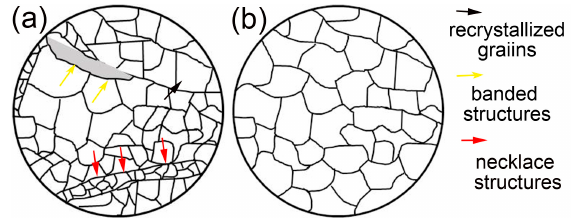
Figure 9. Schematic diagram of the classified microstructures: ( a ) partially recrystallized; ( b ) fully recrystallized.